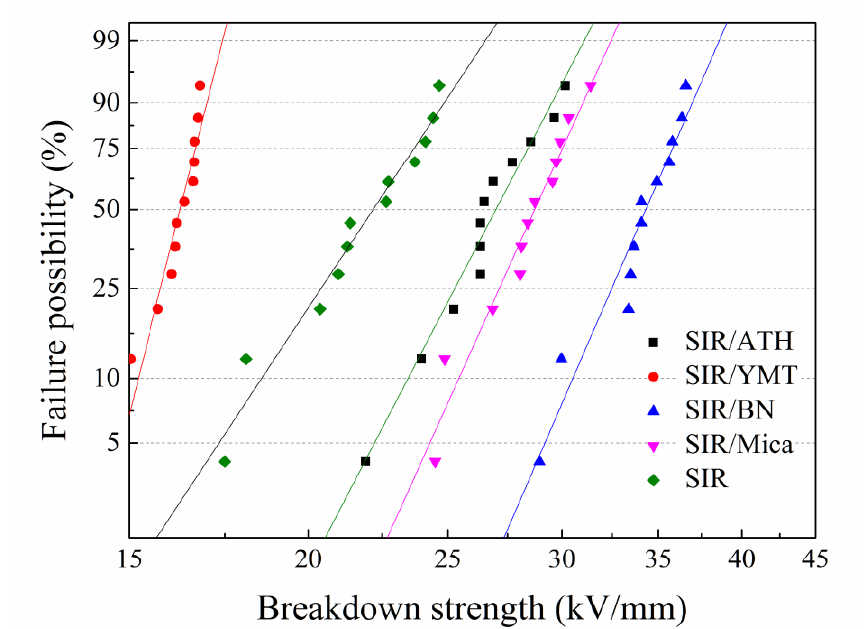
Figure 4. Weibull distribution of SIR composites with various fillers.